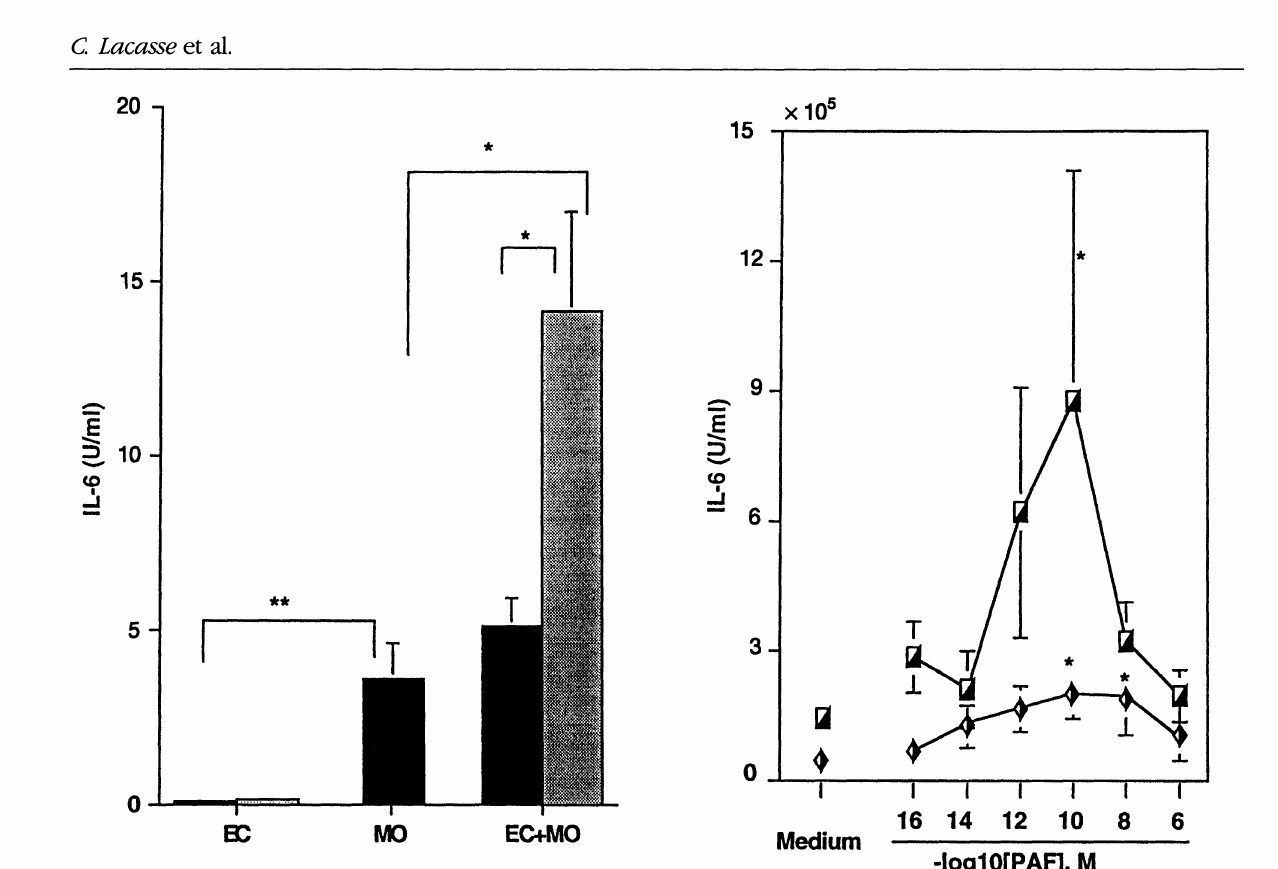
FIG. 1. Synthesis of IL-6 by endothelial cell (EC), monocytes (MO) or co-cultures of both EC and MO. EC were treated for 4 h with either medium or TNF- (25U/ml), washed and incubated for 24h alone or with unstimulated MO. Cultures of monocytes alone were incubated for 24 h in medium. Cell-free supernatants were then collected and IL-6 activity was measured by the B9 cell proliferation assay. Data represent mean -!- S.EoM. of seven to 14 experiments. Statistically significant effects were noted as: *p < 0.005; **p < 0.0005. Pretreatment of EC: [], medium; PAF and TNF.